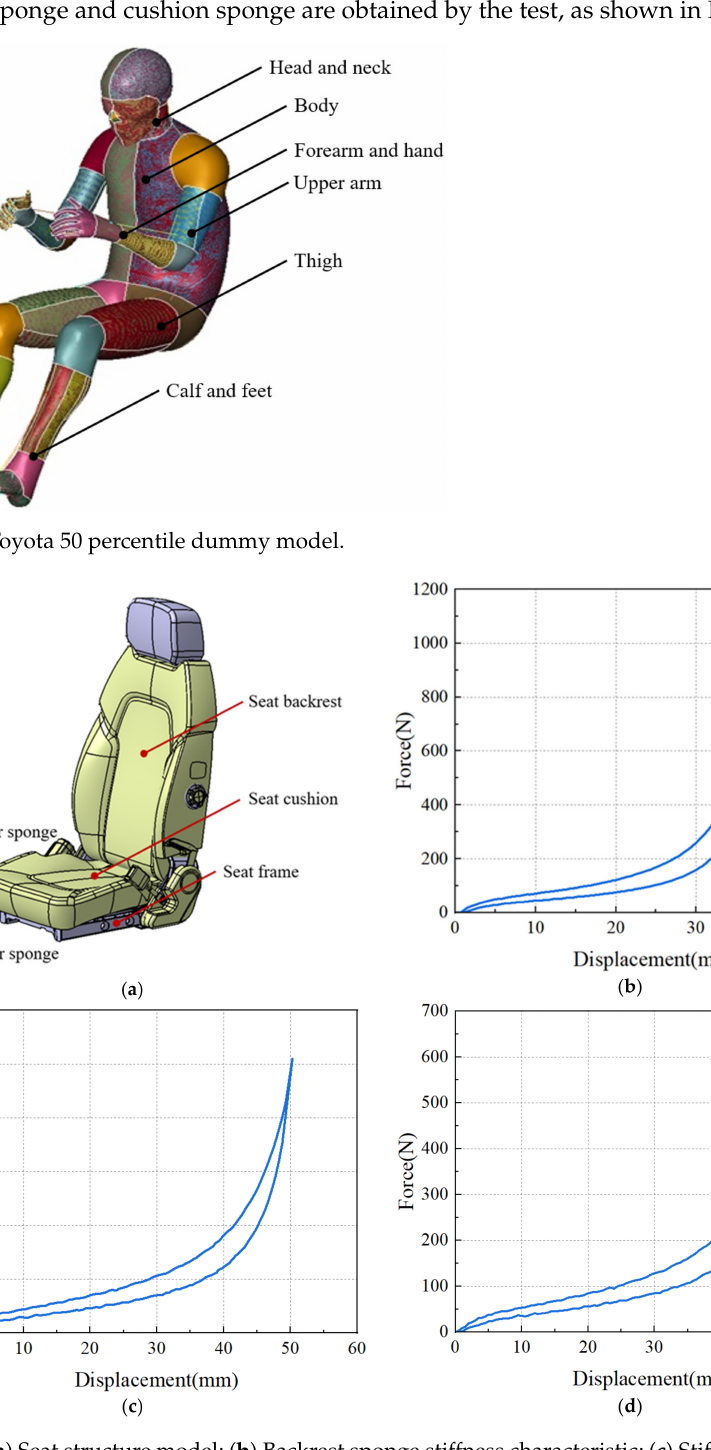
Figure 3. ( a ) Seat structure model; ( b ) Backrest sponge stiffness characteristic; ( c ) Stiffness characteris- tic of upper cushion sponge; ( d ) Stiffness characteristic of lower cushion